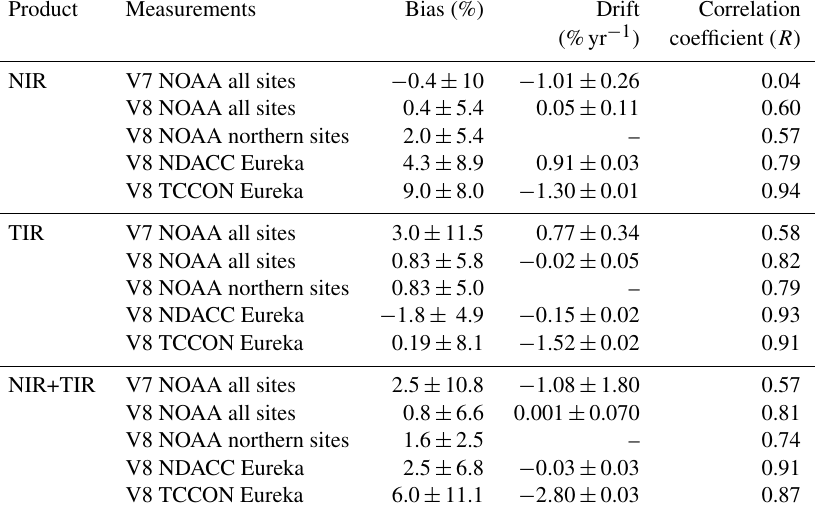
Table 3. Comparison between NIR, TIR, and joint TIR–NIR results presented in Table 3 of Deeter et al. (2019) for MOPITT V7 and V8 data for all NOAA stations (rows 1 and 2) and for the two northernmost NOAA (row 3) stations between 2000 and 2018, along with results from this study for MOPITT V8 (all pixels over land) with NDACC (row 4) and TCCON (row 5). The unit of bias is %, and for drift it is %yr − 1 . The northern NOAA measurements are for the Poker Flat station in Alaska (65.07 ◦ N) and the East Trout Lake station in Saskatchewan (54.35 ◦ N). The northern results are based on Deeter et al. (2019) (Merritt N. Deeter, personal communication, 2019). The uncertainties presented in rows 4 and 5 for bias values compared with NDACC and TCCON are the standard deviation of the biases (1 σ